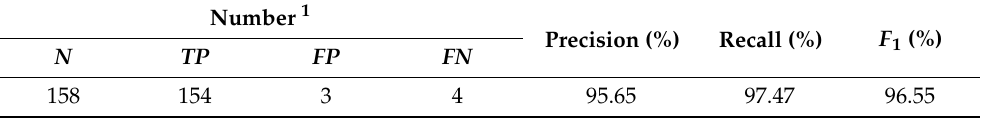
Table 1. Identification results for the P. rapae larvae in the test set.